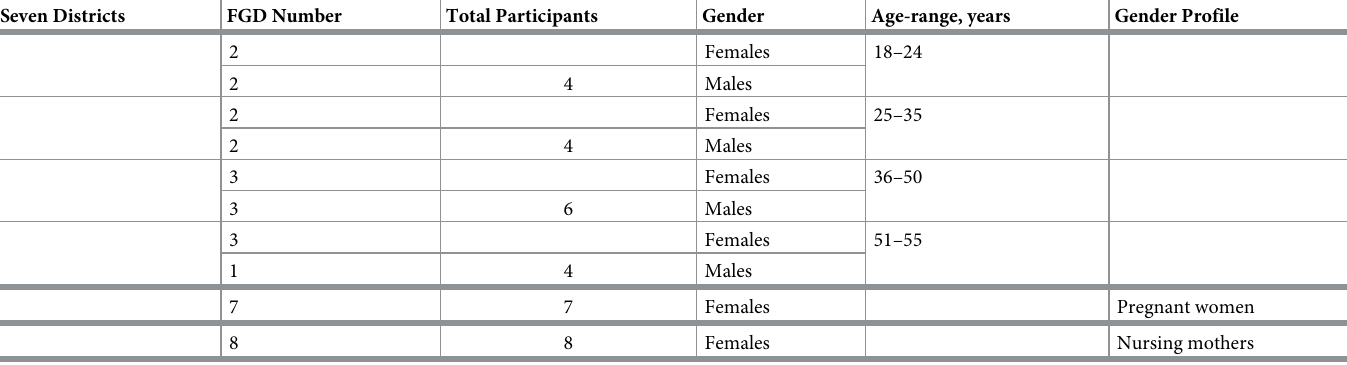
Table 4. Demographic characteristics of FGD participants, Upper East region 2017. Seven